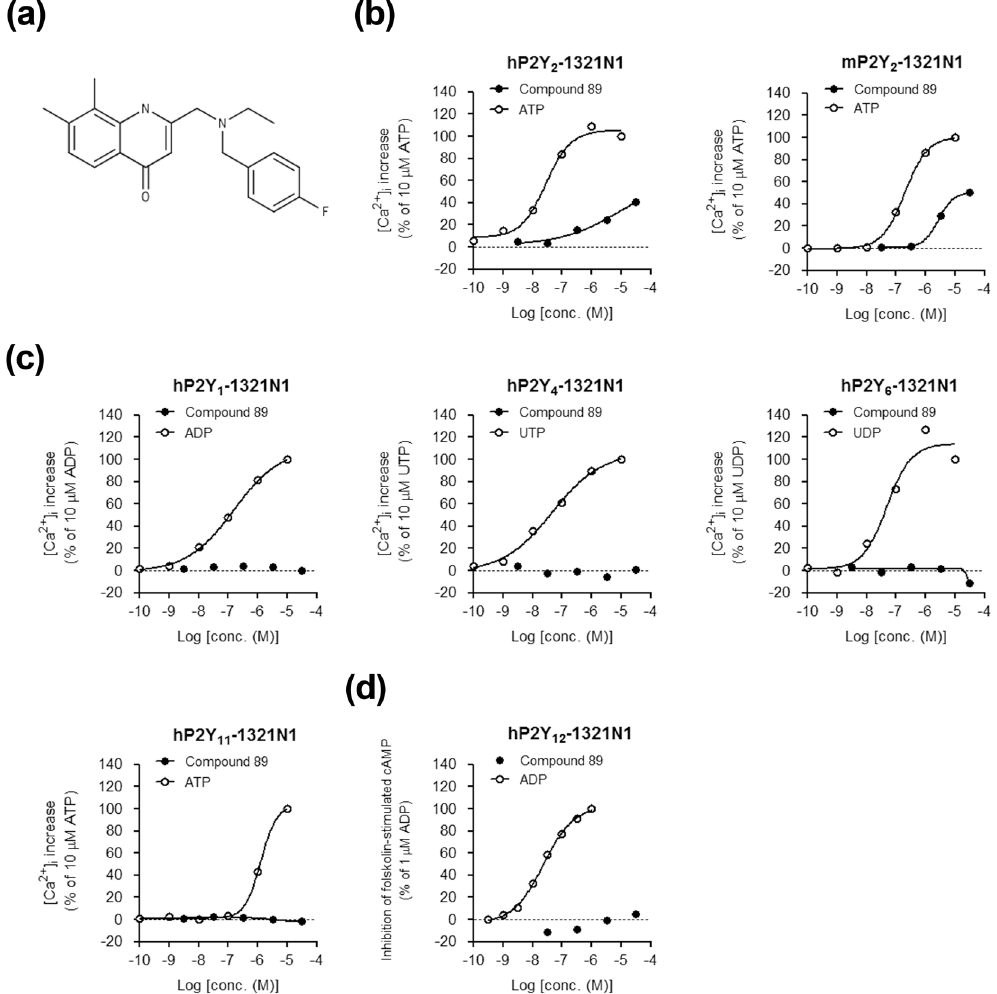
Figure 1. Compound 89 displays selective agonist activity for P2Y 2 in P2Y-overexpressing 1321N1 cells. ( a ) The chemical structure of the 4(1 H )-quinolinone derivative Compound 89: 2-((ethyl(4-fluorobenzyl)amino) methyl)-7,8-dimethylquinolin-4(1 H )-one. ( b ) Agonistic activity against human and mouse P2Y 2 receptors in a FLIPR Ca 2 + mobilization assay using 1321N1 cells that were transiently-expressing hP2Y 2 receptors (hP2Y 2 -1321N1) and stably-expressing mP2Y 2 receptors (mP2Y 2 -1321N1). The activity of 10 μ M ATP was normalized to 100%. ( c ) Agonistic activity against human P2Y 1 , P2Y 4 , P2Y 6 , and P2Y 11 receptors in FLIPR Ca 2 + mobilization assays utilising their respective transiently-expressing 1321N1 cells. The agonistic activity of 10 μ M ADP for hP2Y 1 , UTP for hP2Y 4 , UDP for hP2Y 6 , and ATP for hP2Y 11 was normalized to 100%. ( d ) Agonistic activity against human P2Y 12 receptor in a cAMP accumulation assay using stably-expressing hP2Y 12 -1321N1 cells. The activity of 1 μ M ADP was normalized to 100%. All data points represent the mean in duplicate or quadruplicate and comparable results were obtained from another independent